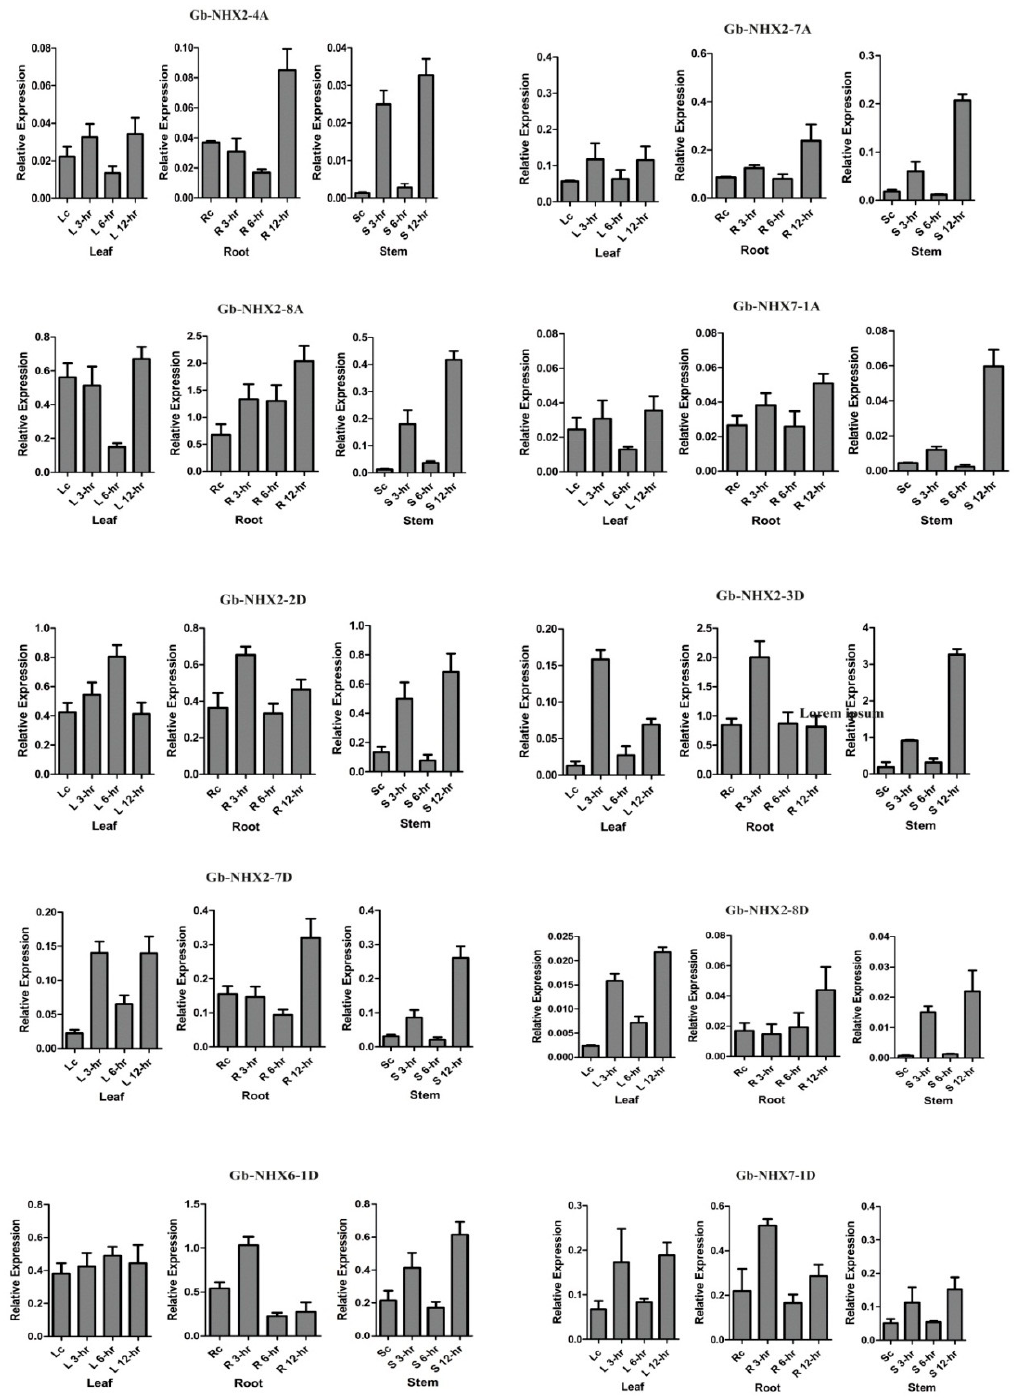
Figure 7. Relative expressions of 10 GbNHX genes under salinity stress based on a qRT-PCR. The values are the means ± standard deviations (SD) of three replicates. Gene specific primers list is provided in Table S3.